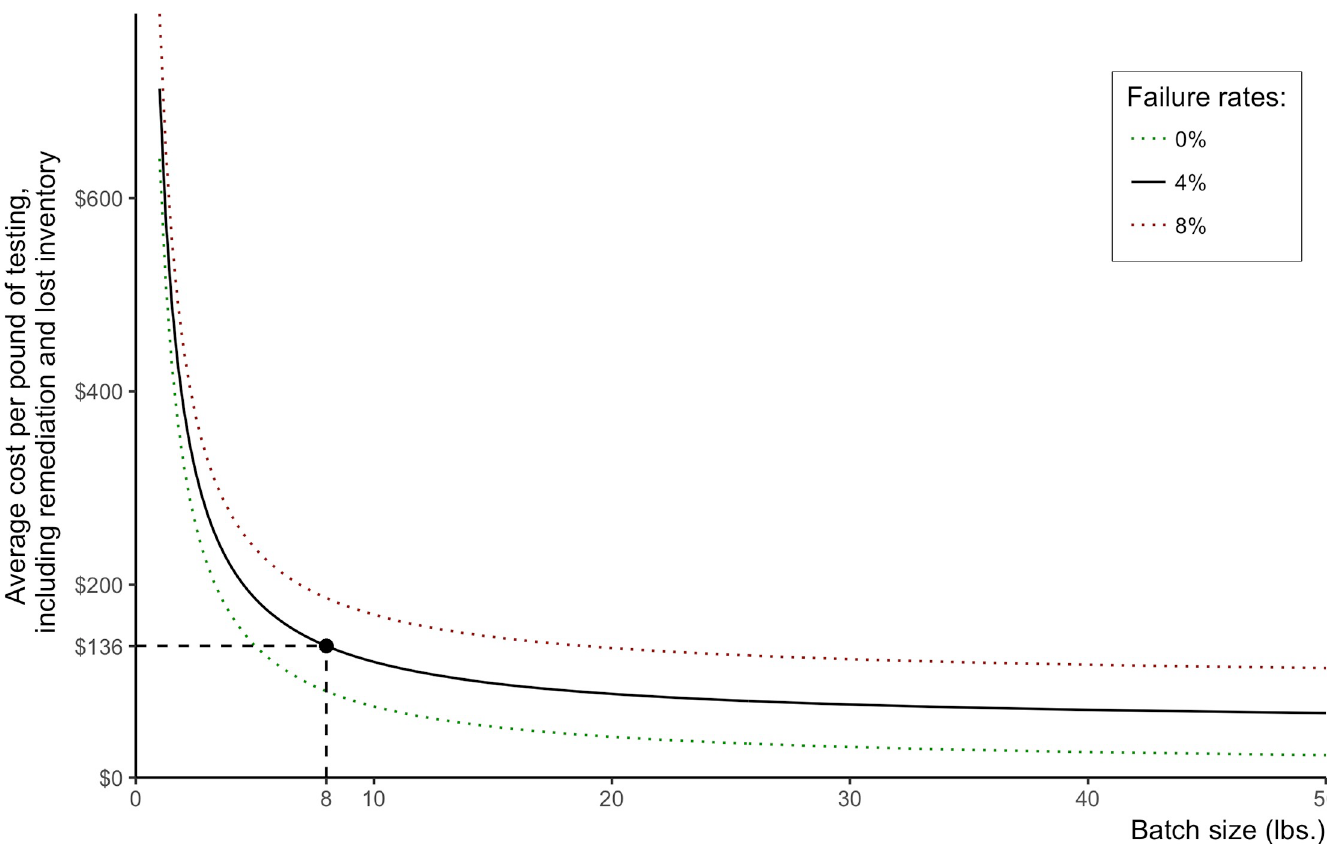
Fig 5. Testing costs per pound of cannabis marketed at different batch sizes and rejection rates.